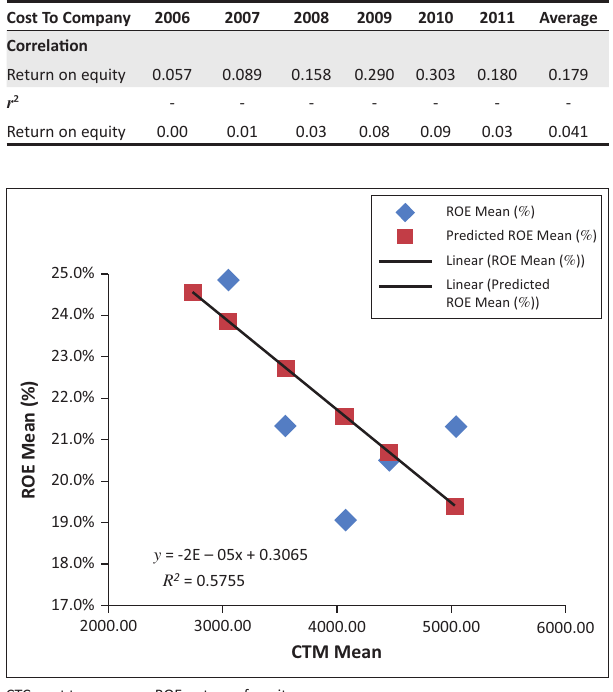
TABLE 9: Correlation and r 2 table − Guaranteed cost to company and return on equity ( % ).